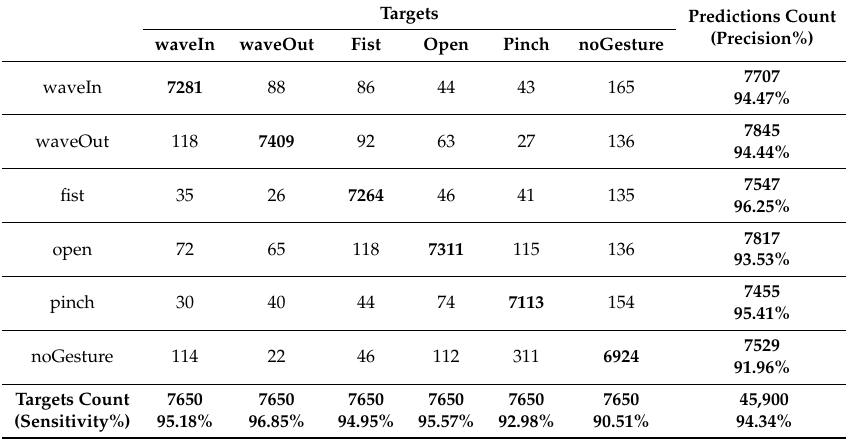
Table A11. Confusion matrix for experiment 3 . Synchronization gestures ( sync = 3 ) .